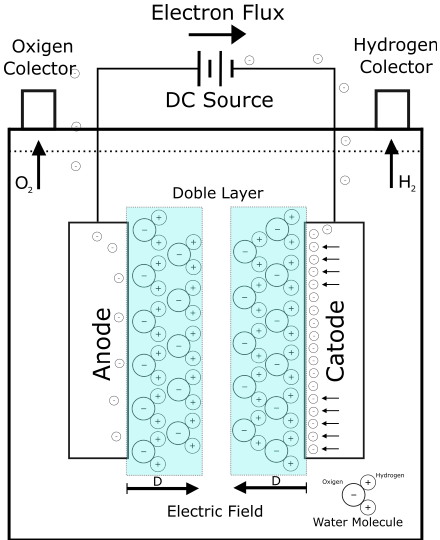
Figure 1. Electrolysis cell and formation of the double layer proportional to the electric field. The voltage needed for the electrolysis of water therefore starts at around 1.63 V (thermo-neutral voltage